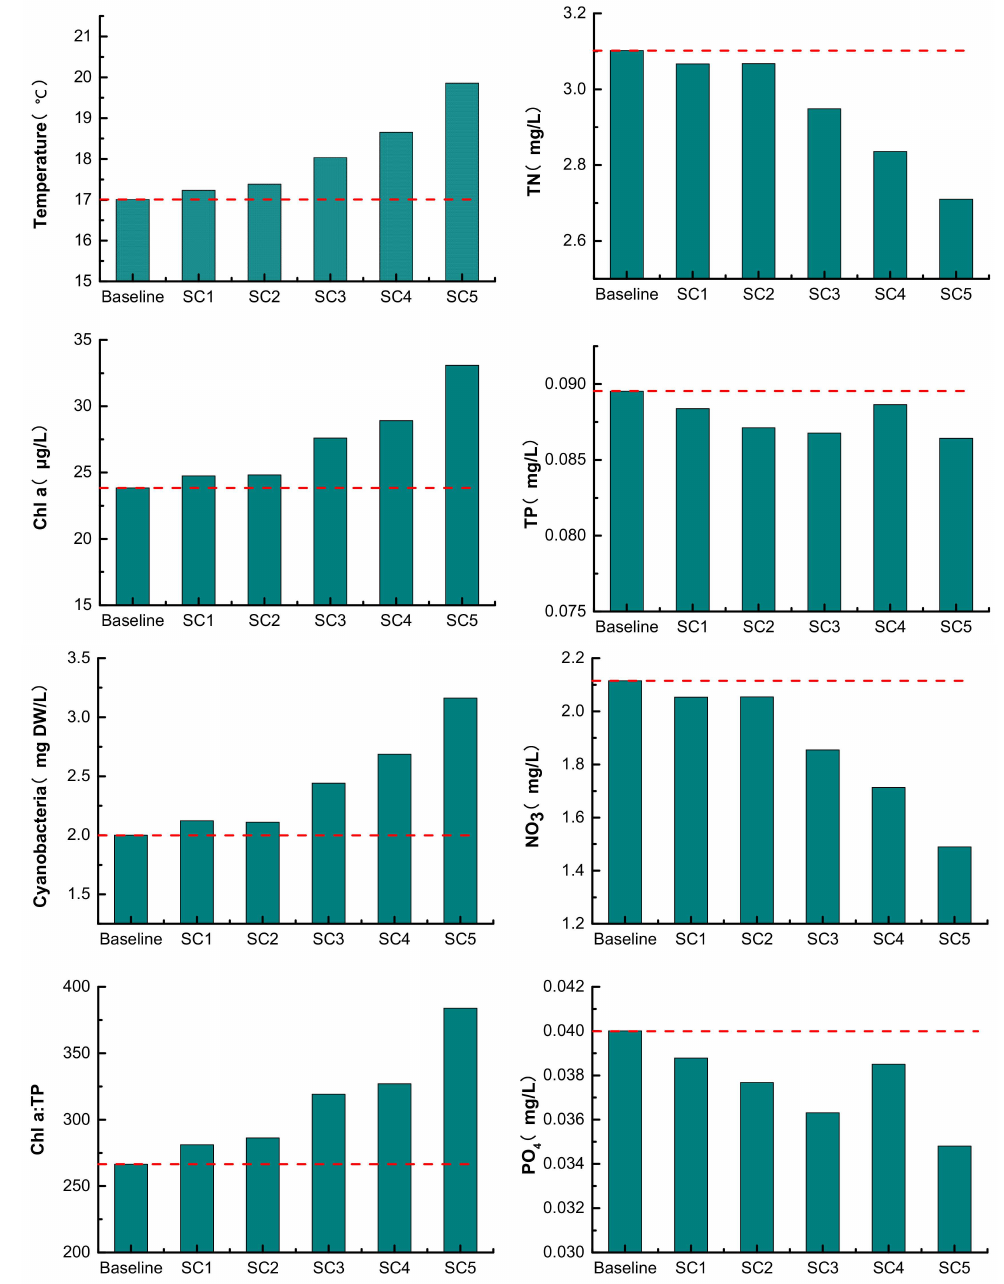
Figure 3. Simulated e ff ects of extreme summer weather on water temperature, TN, TP, Chl a concentration, cyanobacteria biomass, NO 3 , Chl a:TP ratio, and PO 4 in the surface of Lake Bryrup based on summer averages from daily values during the last five